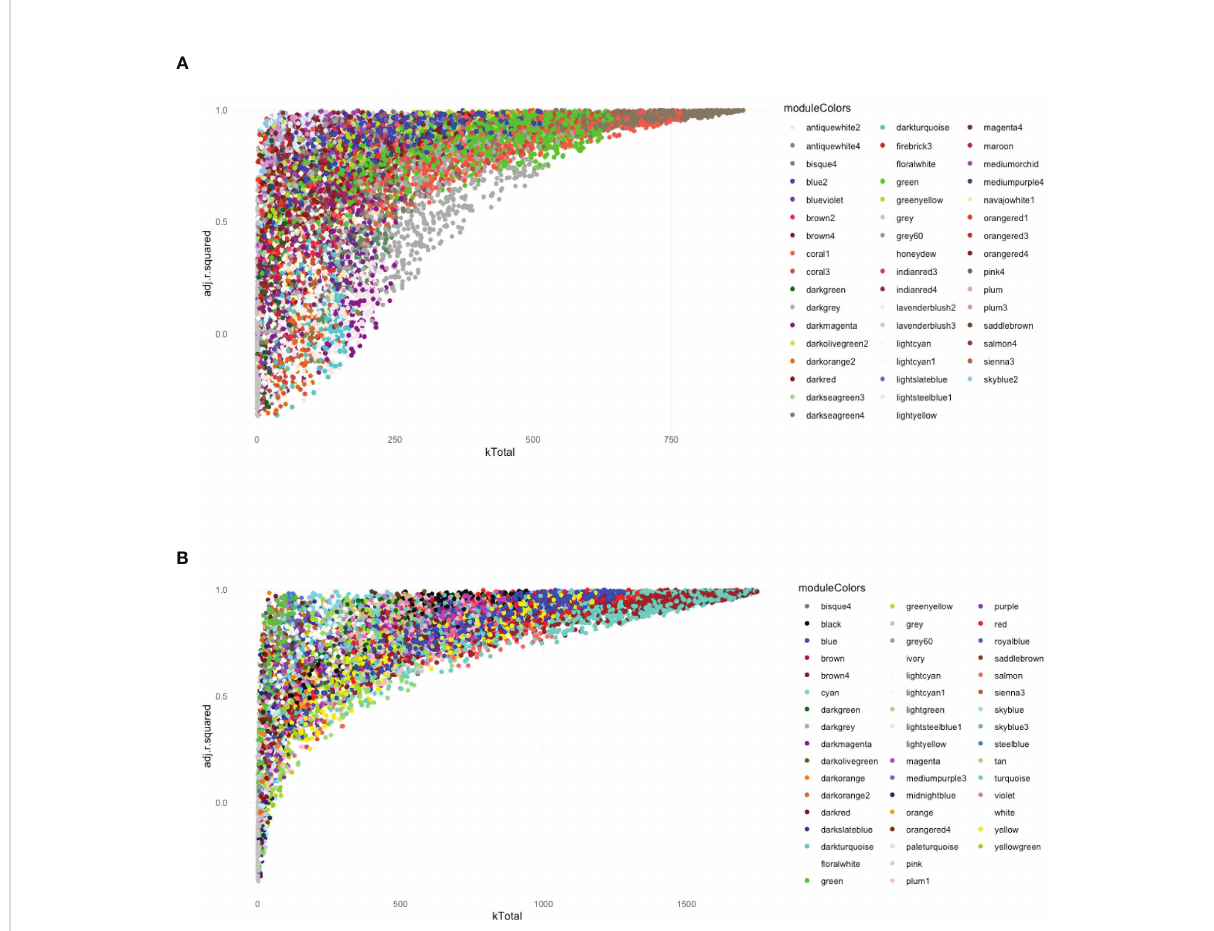
FIGURE 3 The global network analysis of WT-infected macrophages highlights modules with highly connected genes that explain most of the variance of the data (highly adjusted R-squared). (A) Scatter plot of kTotal (whole network connectivity) against adjusted R-squared for all genes in an 8-h network. Genes are colored according to the module (described in Figure 2) they belong to. (B) Scatterplot of kTotal (whole network connectivity) against adjusted R squared for all genes in the 24 h network. Genes are colored according to the module (described in Figure 2) they belong